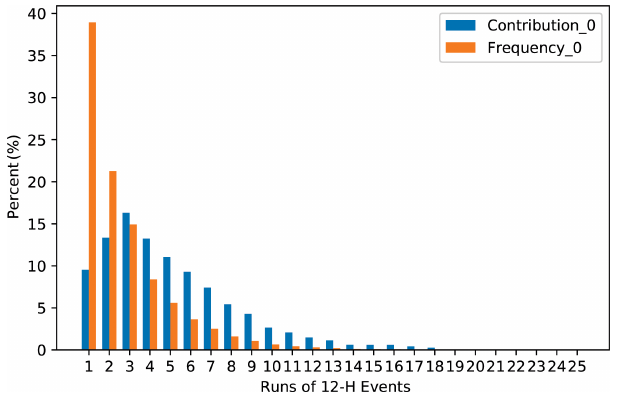
Figure 2. Frequency and contribution of runs of 12h